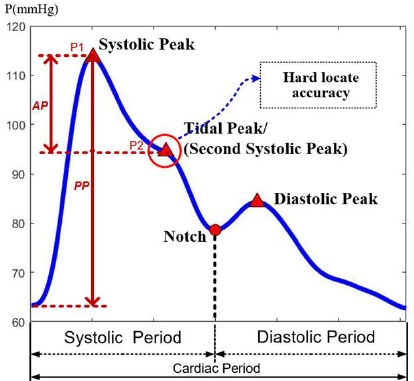
Figure 2. Pulse waveform and location of feature points.